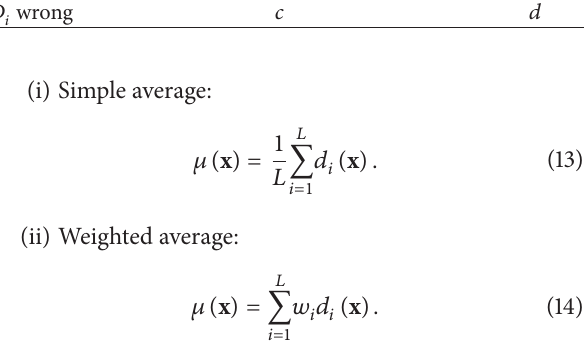
Table 6: Joint probabilities of two classifiers; 𝑎 + 𝑏 + 𝑐 + 𝑑 = 1 . 𝐷 𝑖 correct